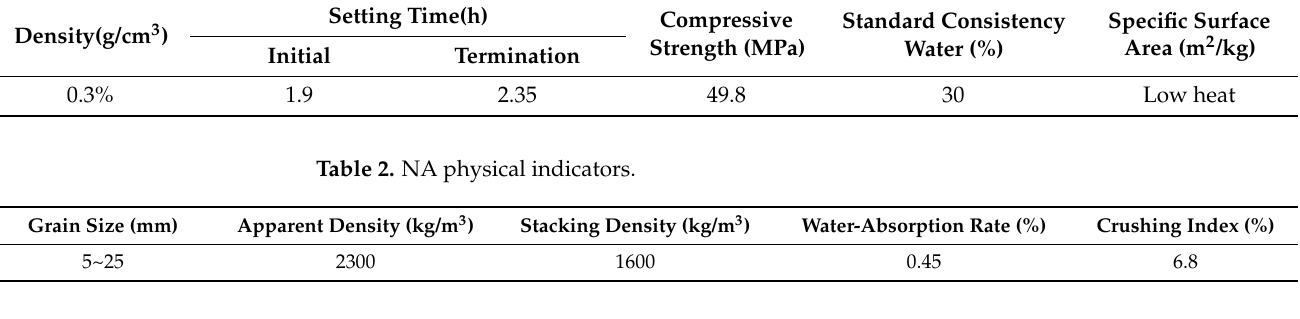
Table 3. RCA physical indicators.